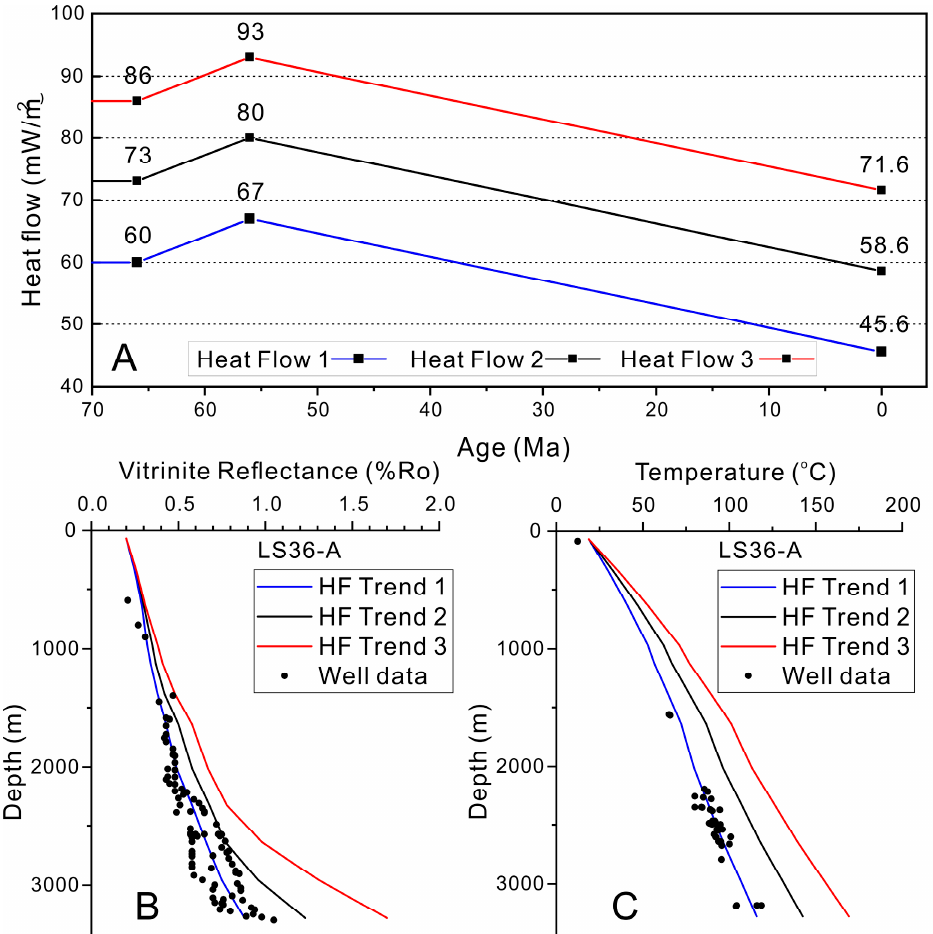
Figure 12. ( A ) The heat flow trends used to recover the paleo heat flow in the Lishui Sag. Heat flow 1 refers to the minimum trend and heat flow 3 refers to the maximum trend. The heat flow uncertainty is estimated to be 13 mW/m 2 above or below that of heat flow trend 2. ( B ) The vitrinite reflectance simulated using the three heat flow trends (curves with different colors) and measured data (dots). ( C ) The formation temperature calculated using different heat flow trends and measured data.